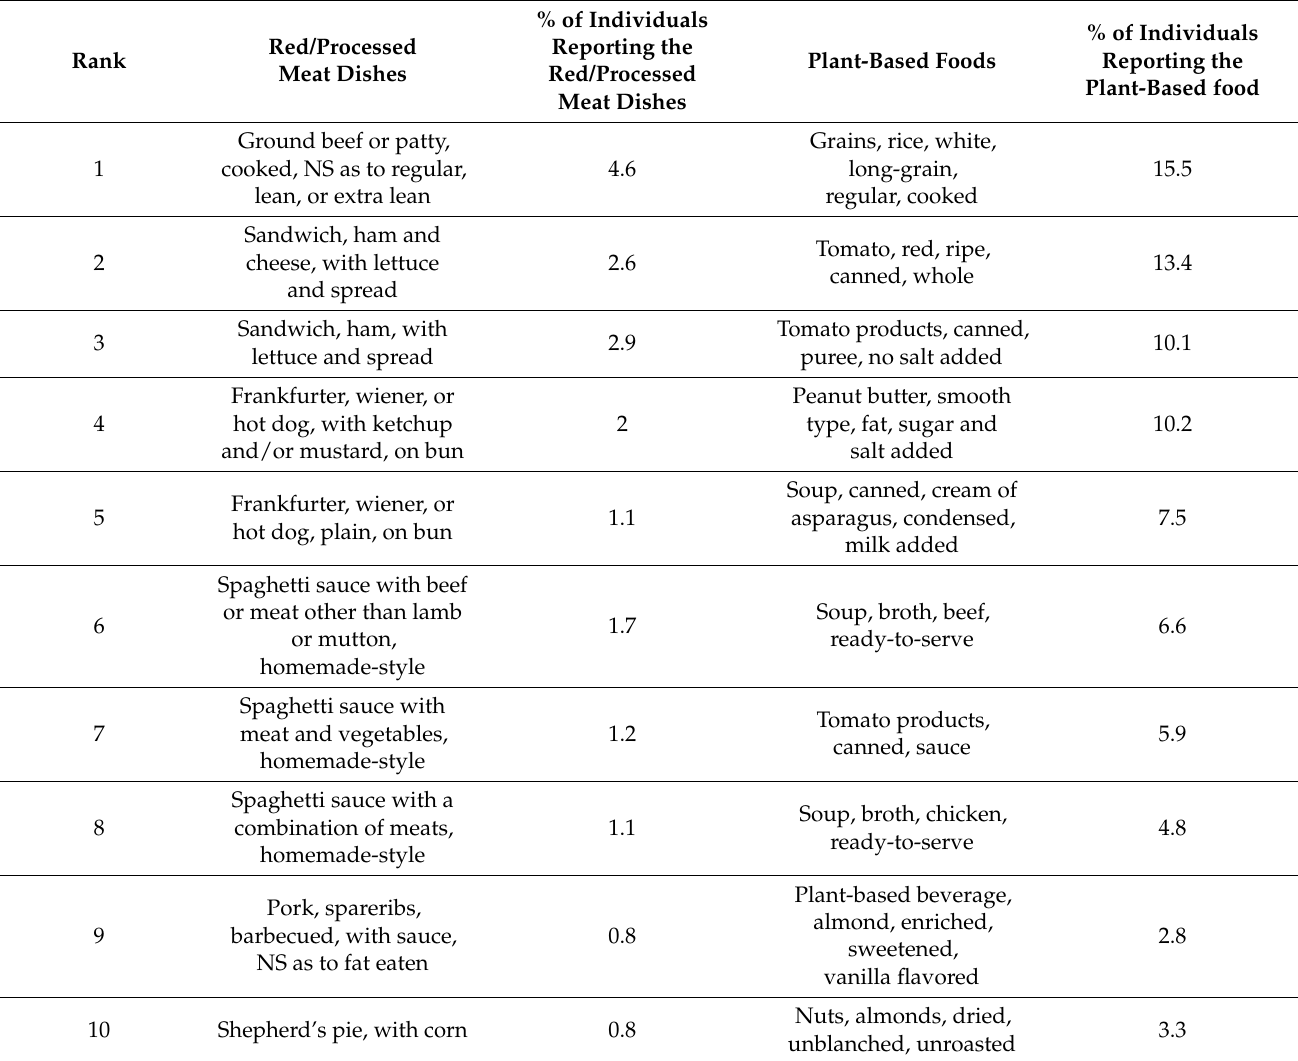
Table 1. Top 10 most frequently reported plant-based foods and red/processed meat dishes among individuals ≥ 1 year in Canada ( n = 20,176), 2015 Canadian Community Health